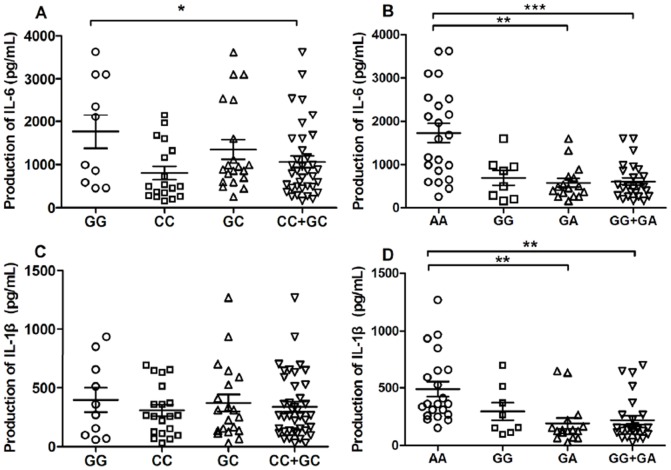
The production of IL-6 and IL-1β with different genotypes of miR146a polymorphisms in PBMCs under the LPS stimulation.(A) The IL-6 production with rs2910164 polymorphism; (B) The IL-6 production with rs57095329 polymorphism; (C) The IL-1β production with rs2910164 polymorphism; (D) The IL-1β production with rs57095329 polymorphism. The horizontal line indicates the mean expression level with each genotype groups. *p<0.05; **p<0.01; ***p<0.001.